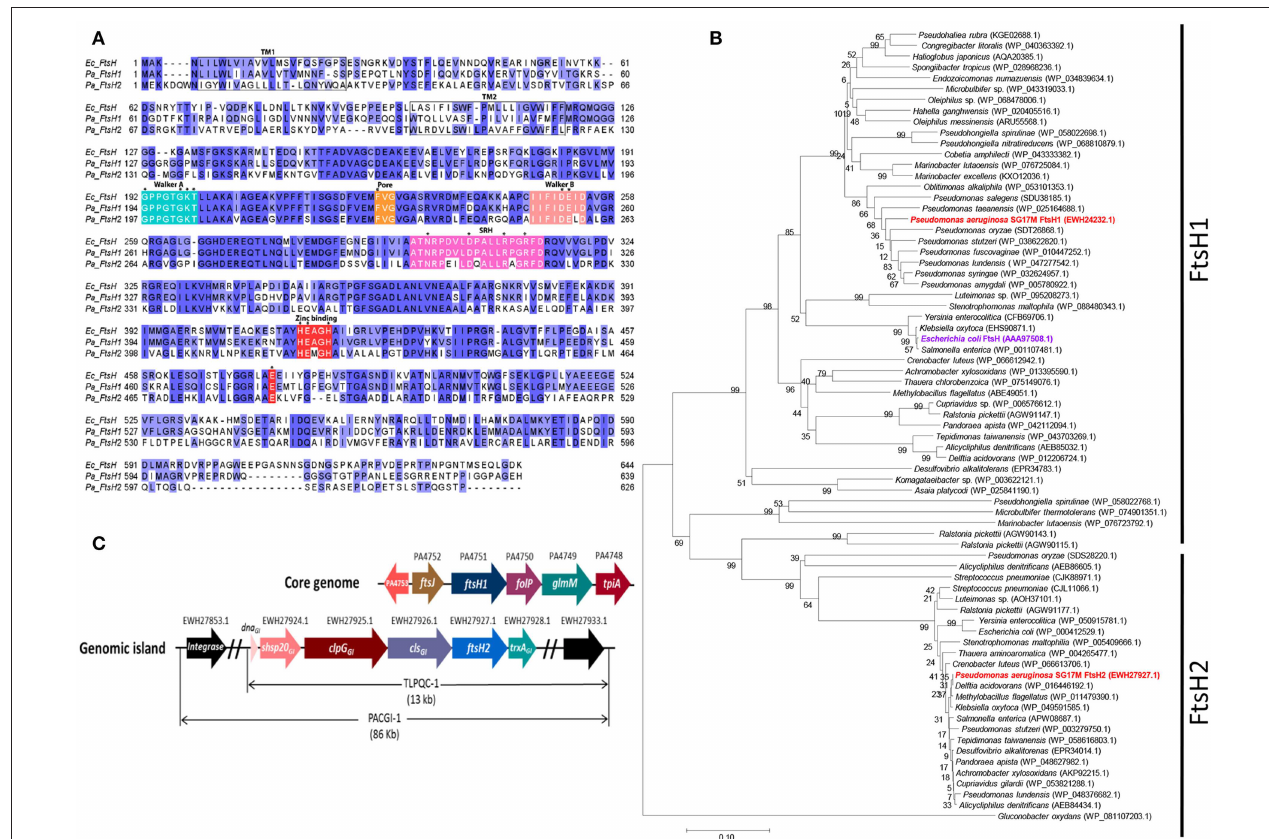
FIGURE 1 | Homology, phylogeny and genomic context of FtsH1 and FtsH2. (A) Alignment of FtsH proteases from E. coli K12 and P. aeruginosa SG17M . E. coli FtsH (Ec_FtsH; AAA97508.1), P. aeruginosa SG17M core genome copy FtsH1 (Pa_FtsH1; EWH24232.1) and genomic island copy FtsH2 (Pa_FtsH2; EWH27927.1). Residues on a dark blue background indicate 100% conservation, while residues on a light blue background indicate 66% conservation. Different background colors indicate regions of functional motifs. Functional amino acids for ATP binding, substrate translocation and catalytic activity are labeled with an asterisk ( * ). Transmembrane segments TM1 and TM2 and the second region of homology (SRH) are also indicated. FtsH1 and FtsH2 of P. aeruginosa SG17M are 76 and 43% identical to E. coli FtsH, respectively. Sequences were aligned with MUSCLE using default settings ( Edgar, 2004) and displayed in JalView (Waterhouse et al., 2009). (B) Phylogenetic analysis of closest homologs of FtsH1 and FtsH2 proteins from different taxonomic groups of bacteria. Examples of strains with multiple FtsH1/FtsH2 homologs are included in the tree: Ralstonia pickettii DTP0602 (4 homologs), Alicycliphilus denitrificans K601 (3 homologs), Pseudomonas ludensis (2 homologs), and Streptococcus pneumoniae SMRU2535 (3 homologs). Gluconobacter oxydans FtsH is included as outgroup. Branch lengths correspond to substitutions per site, bootstrap values are indicated in %. The sequence accession numbers are shown in parenthesis. (C) Neighboring genes flanking ftsH1 on the core genome and ftsH2 on the genomic island. Genes upstream of ftsH1 are ftsJ (EWH24233.1) and a divergently transcribed PA4752 encoding a conserved hypothetical protein (EWH24234.1), while genes downstream are folP (dihydropteroate synthase - EWH24231.1), glmM (phosphoglucosamine mutase - EWH24230.1), and tpiA (triosephosphate isomerase- EWH24229.1). Genes upstream of ftsH2 are cls (cardiolipin synthase), disaggregase encoding clpG GI , small heat shock protein encoding shsp20 GI and transcription factor encoding dna GI , whereas the downstream gene is trxA GI